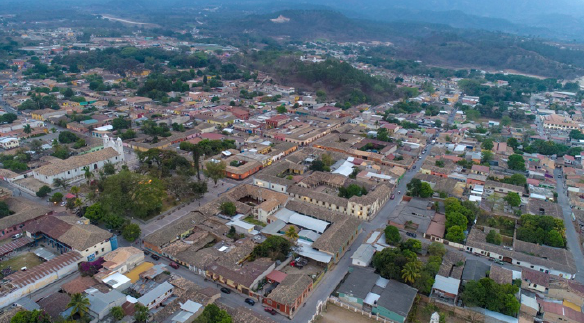
Figure 1. Aerial view of the historical centre of